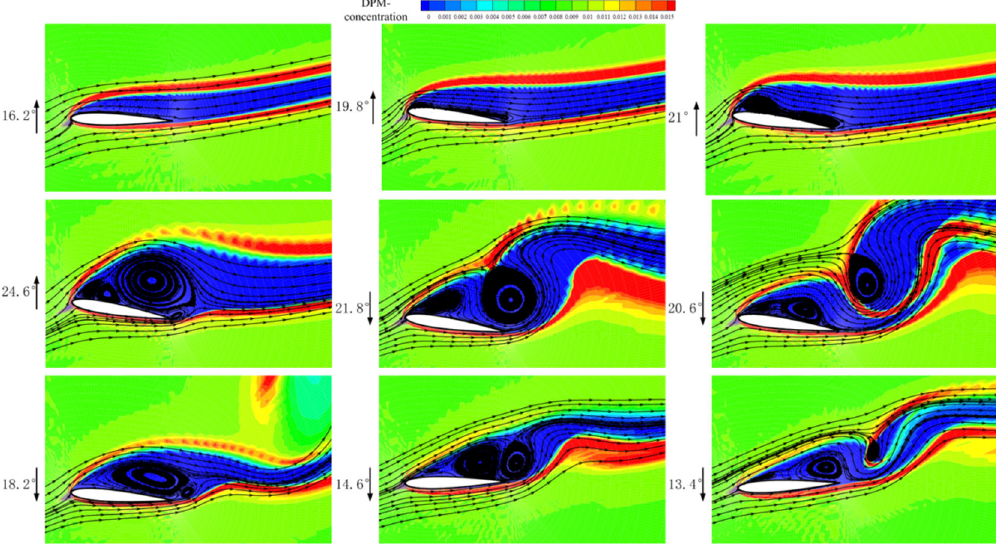
Figure 10. Streamline and particle mass concentration distribution when the airfoil moves to different angles of